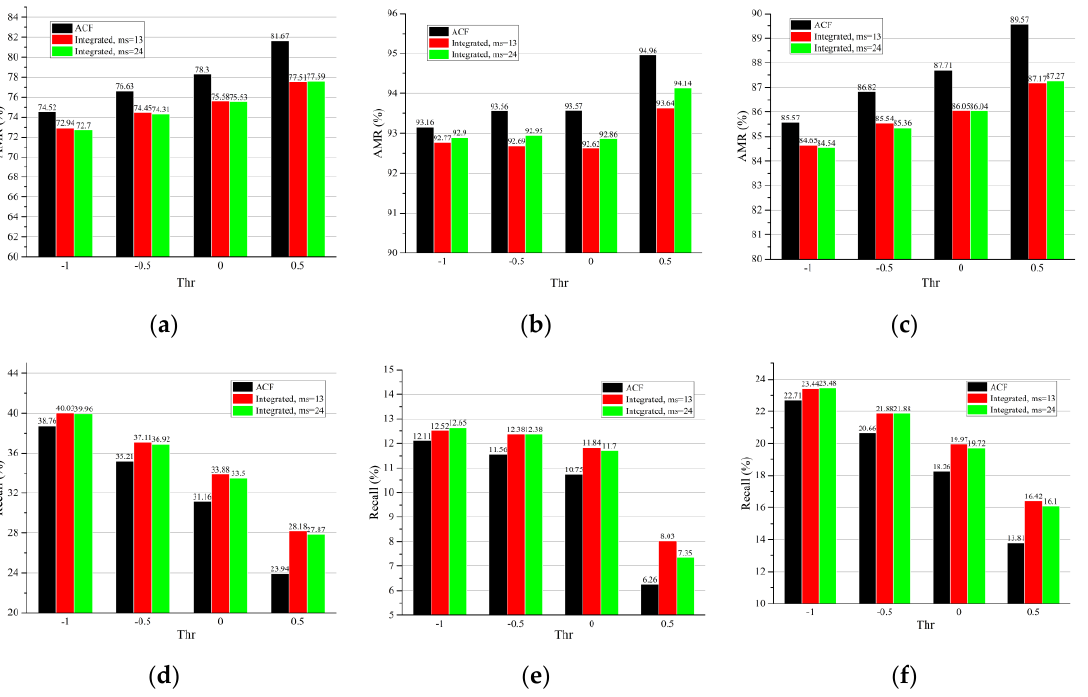
Figure 24. The AMR and recall of the reasonable subset ( a , d ), heavily occluded subset ( b , e ), and all subset ( c , f ) for the Citypersons validation set. The ACF detector was pretrained on the INRIA dataset.